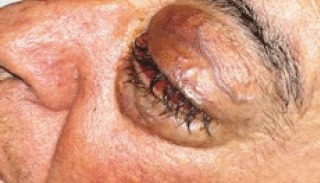
Detail of left eye.